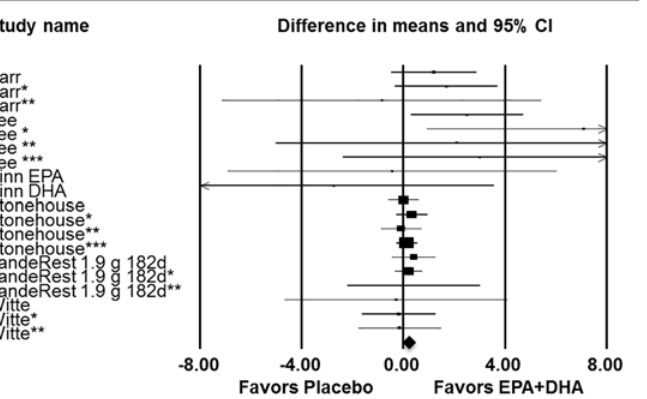
Fig 3. Forest plot with meta-analysis of dose and episodic memory. Episodic memory data from pertinent human intervention studies (n = 6) of DHA supplementation alone or in combination with EPA > 1g in all adults. * Asterisks denote study included more than one test of episodic memory, results for each episodic memory test within a given study represented individually. Summary statistics are as follows z = 1.81 (p = 0.070); Hedge ’ s g z = 2.05 (p =